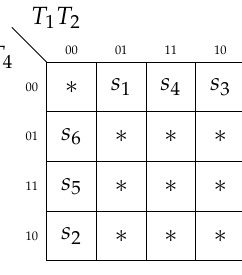
Figure 5. Extended state codes of P E FSM A 0 .